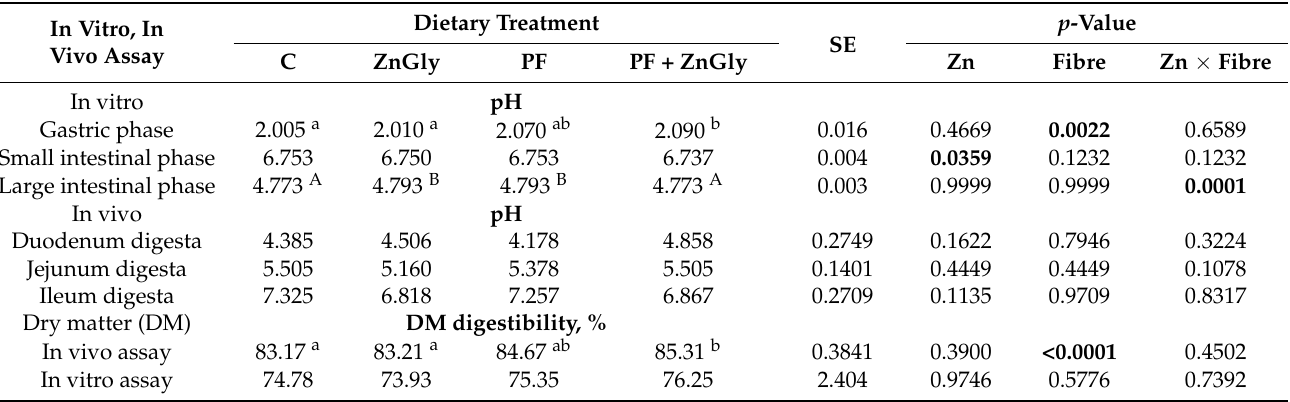
Table 5. Effects of dietary treatments with added Zn and fibre from different sources on pH and dry matter digestibility subjected to in vivo and in vitro digestion